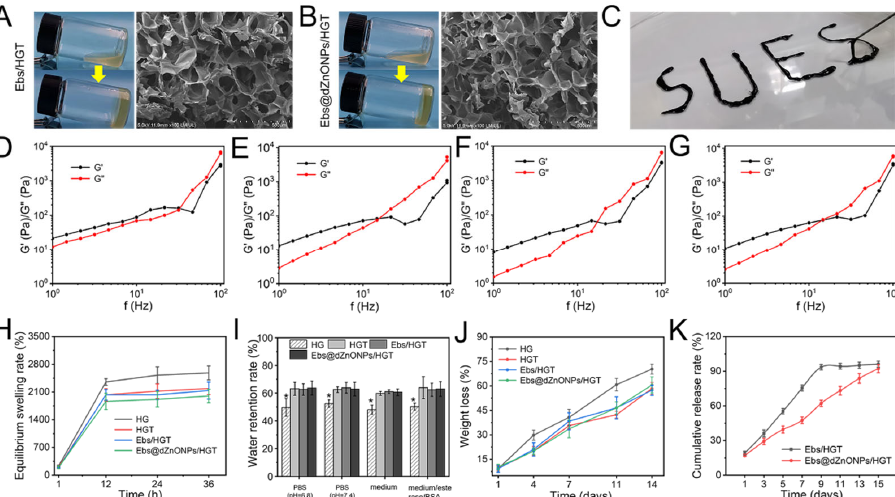
Figure 3. ( A ) Macroscopic image and cross-sectional SEM of Ebs/HGT hydrogel; ( B ) Macroscopic image and cross-sectional SEM of Ebs@dZnONPs/HGT hydrogel; ( C ) Injectability of Ebs@dZnONPs/HGT hydrogel; Frequency sweep testing of HG ( D ), HGT ( E ), Ebs/HGT ( F ) and Ebs@dZnONPs/HGT ( G ) hydrogels; ( H ) Equilibrium swelling of hydrogels in PBS solution (pH = 7.4); ( I ) Water retention of hydrogels after 12 h; ( J ) In vitro degradation of hydrogels; ( K ) In vitro release of Ebs. Data are presented as mean ± standard ( n = 3), * means p < 0.05. Table 1. The preparation parameters of hydrogels for HG, HGT, Ebs/HGT, dZnONPs/HGT and